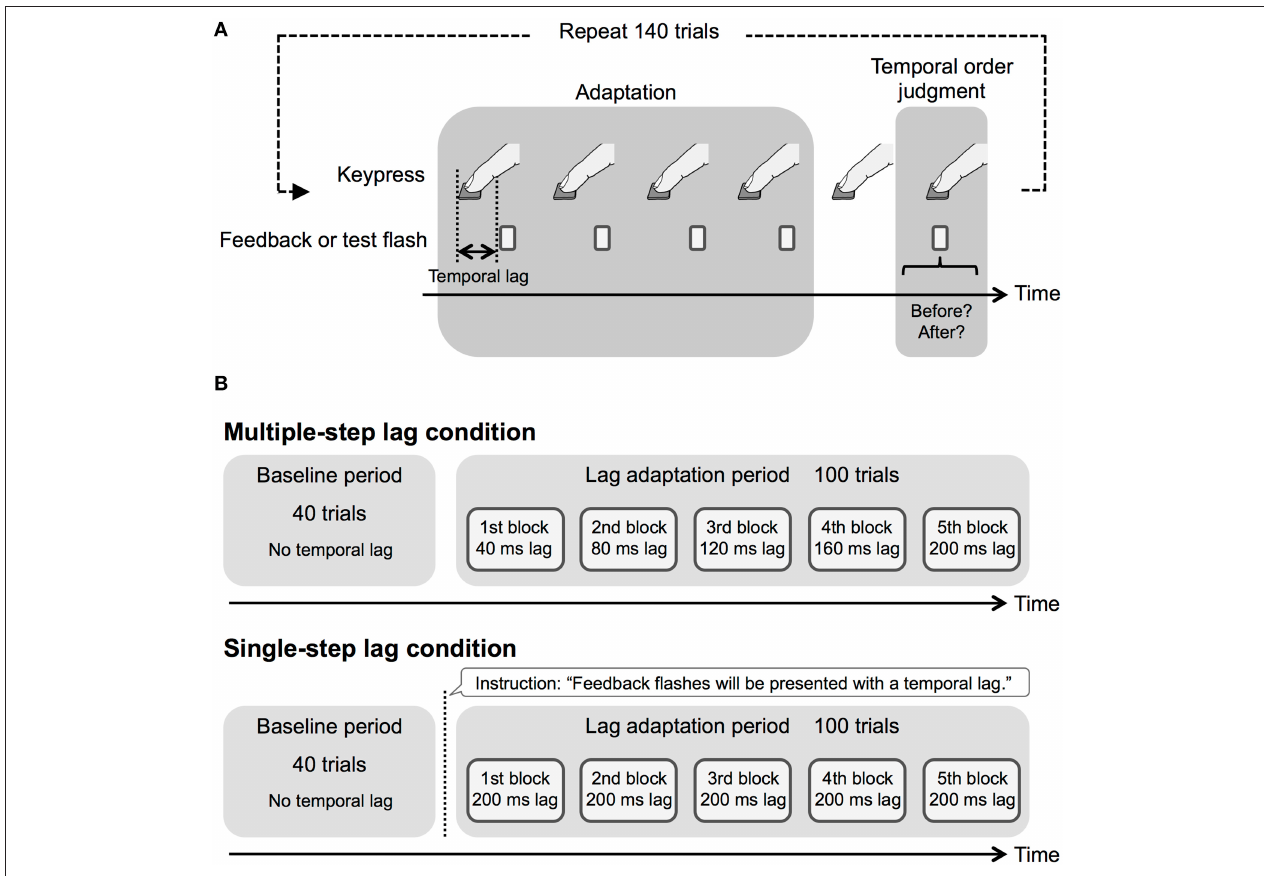
FIGURE 1 | Schematic illustration of procedure in Experiment 1. (A) Experimental run and (B) experimental design in the experimental